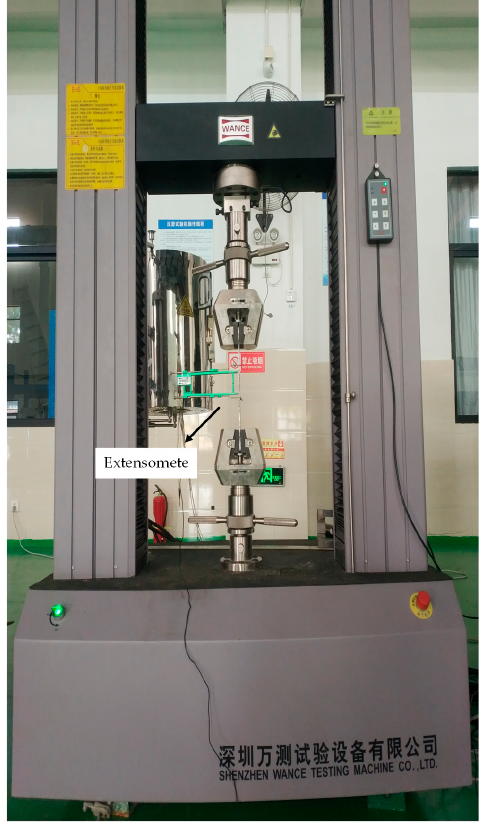
Figure 5. Static tensile test.